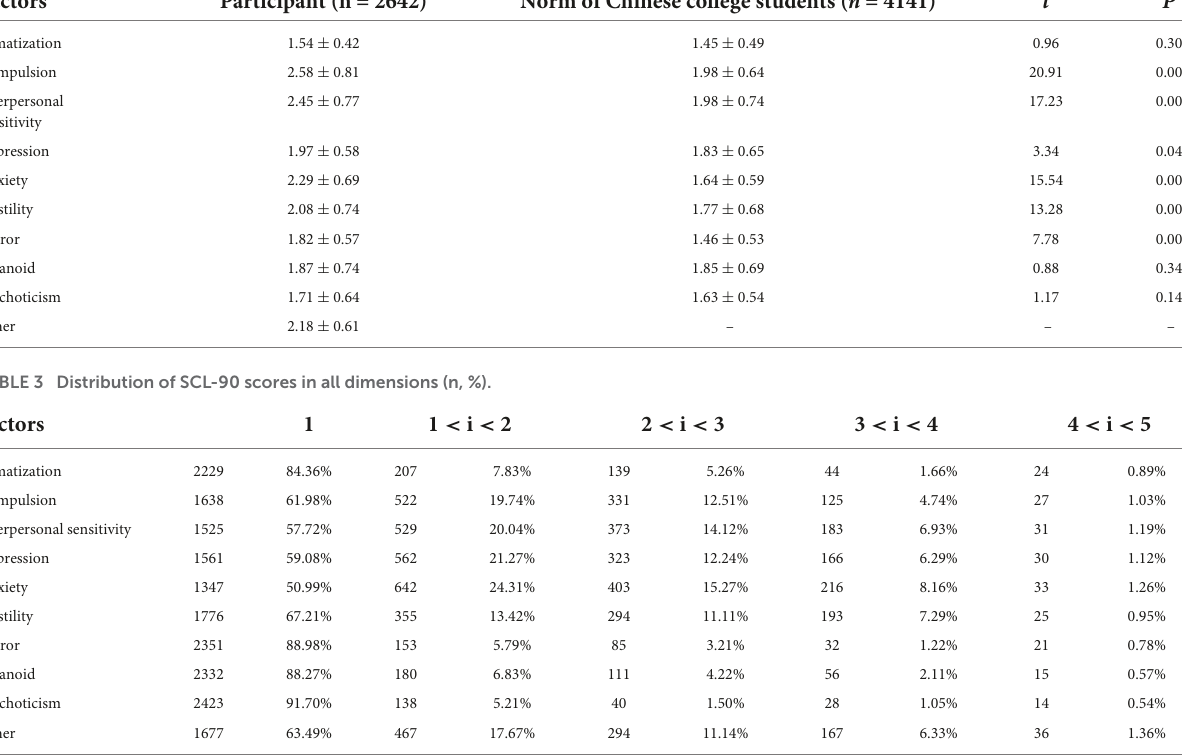
TABLE 2 Comparison of SCL-90 scores with the norms of Chinese college students ( ¯ x ± s). Factors Participant (n = 2642) Norm of Chinese college students ( n = 4141)